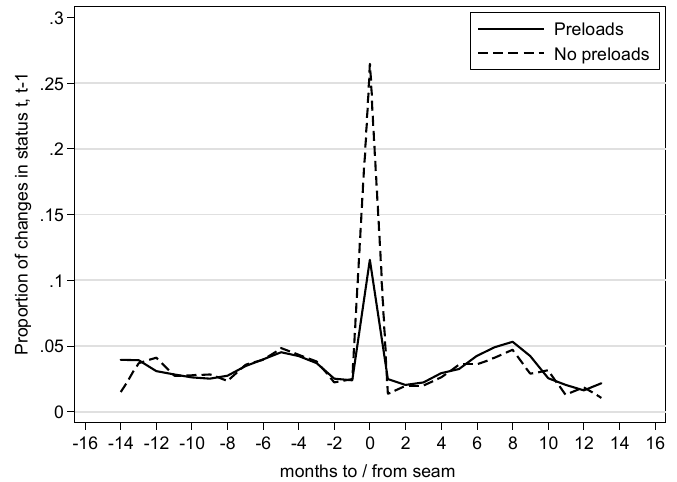
Proportion of cases reporting a change of activity status compared to the previous month. Time line centered at the month following the wave 2